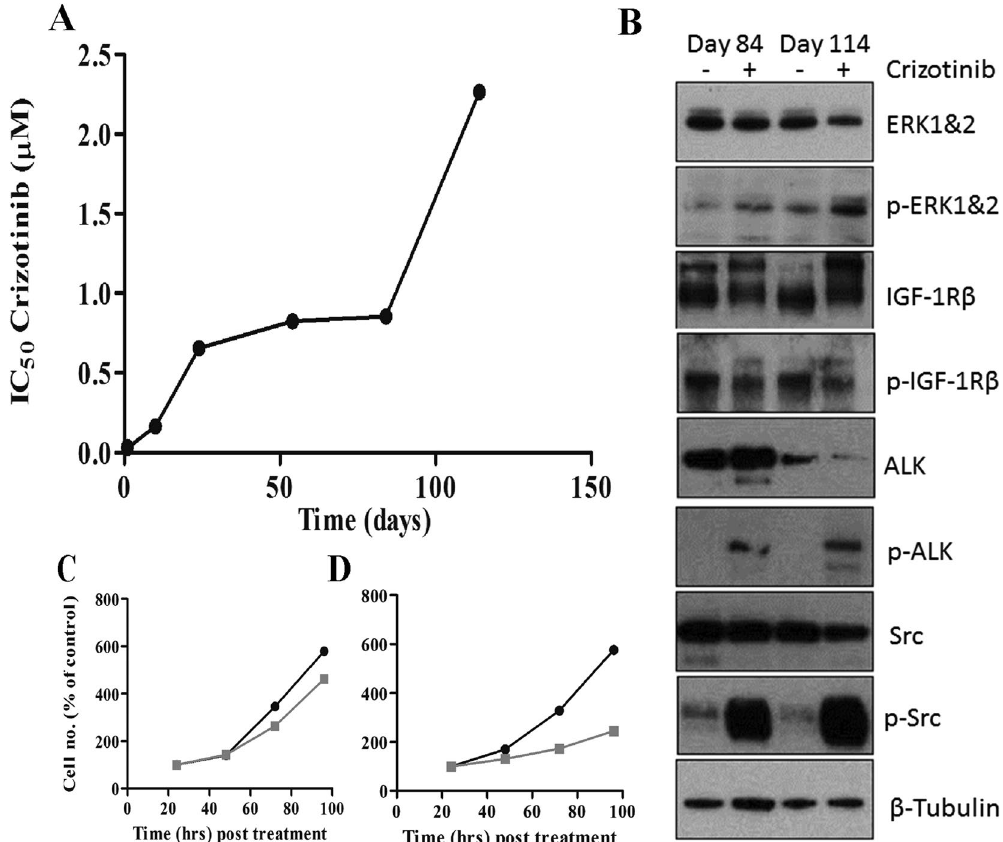
Figure 4. Characterisation of H3122 cells with acquired crizotinib resistance (CR-H3122). ( A ) Change in IC 50 values for cytotoxicity during the course of acquisition of crizotinib resistance. ( B ) Tyrosine kinase expression and activation (phosphorylation) in CR-H3122 cells ( + ) compared with H3122 cells ( − ) at 84 and 114 days following initiation of maintenance of cells in crizotinib (see main text for details). Each antibody was performed on separate blots, as delineated with dividing lines. ( C ) Growth rate of CR-H3122 cells compared to H3122 cells at 84 days and 114 Days ( D